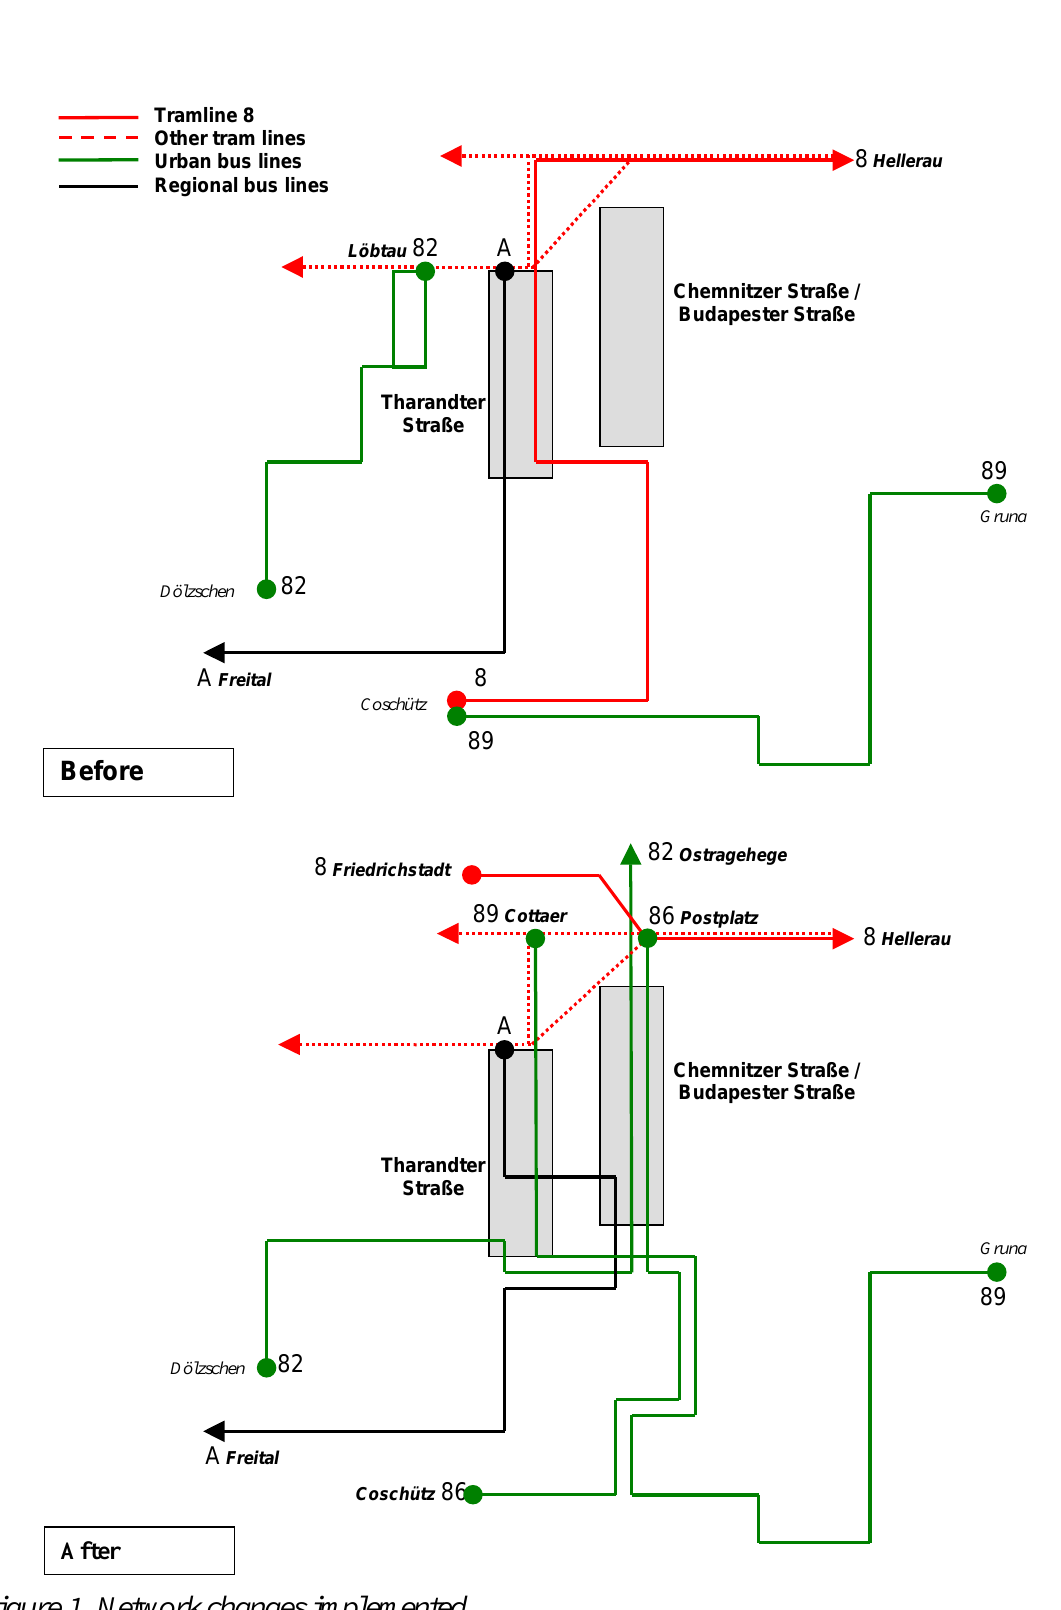
Figure 1. Network changes